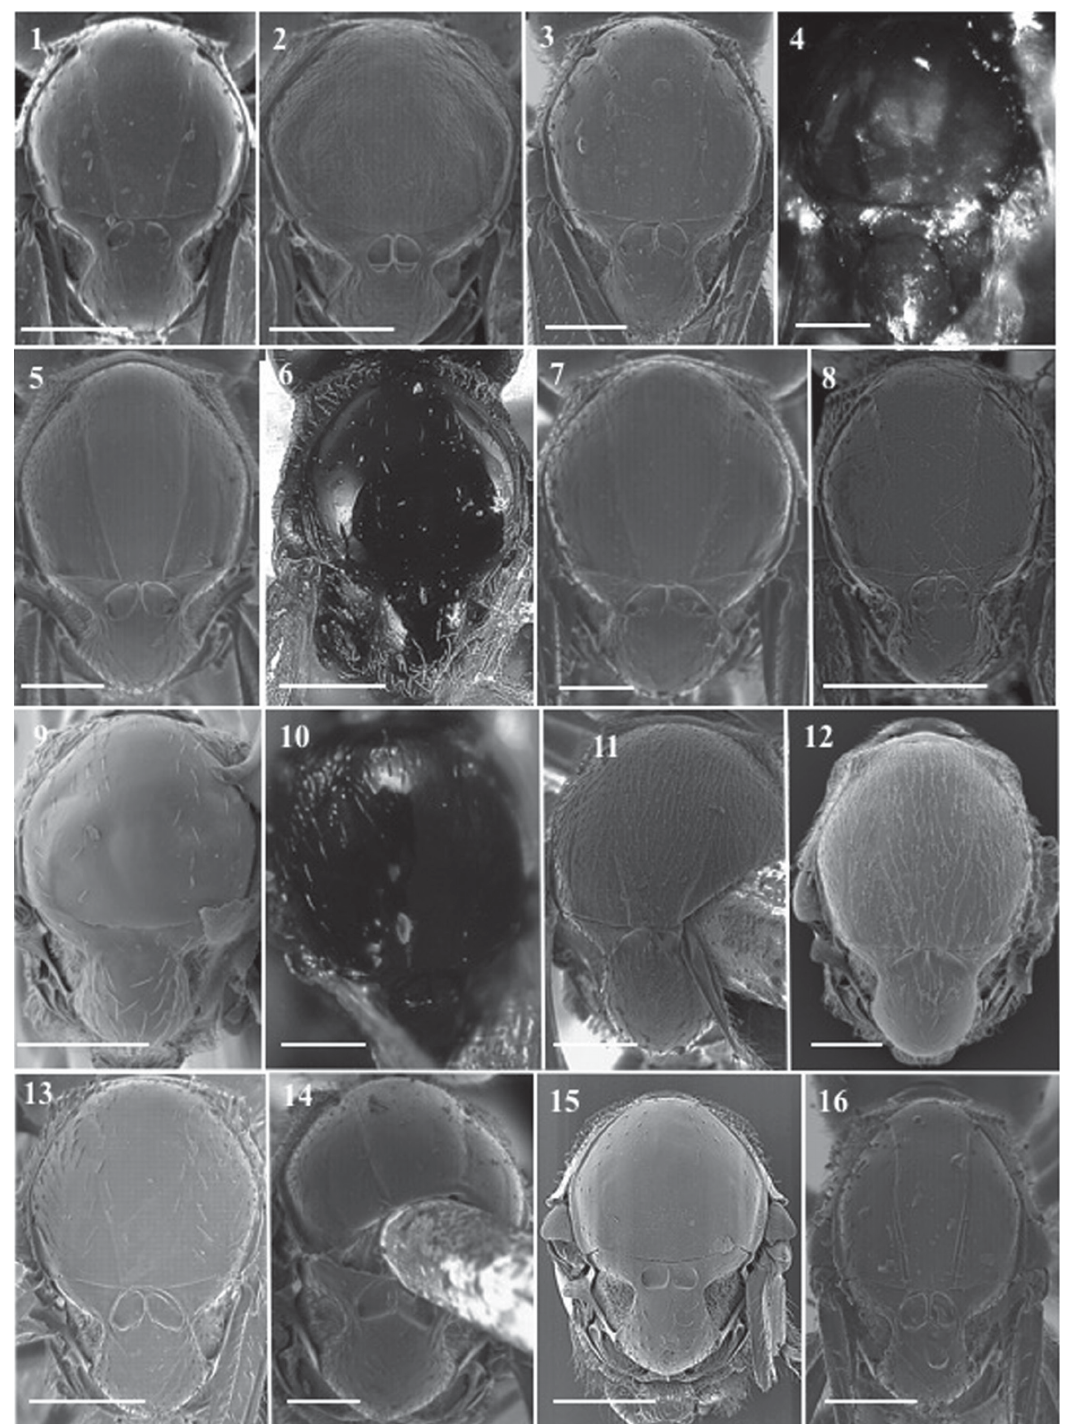
Fig. 7. Types of mesoscutum of Phaenoglyphis Förster, 1869. 1 . P. abbreviata (Thomson,